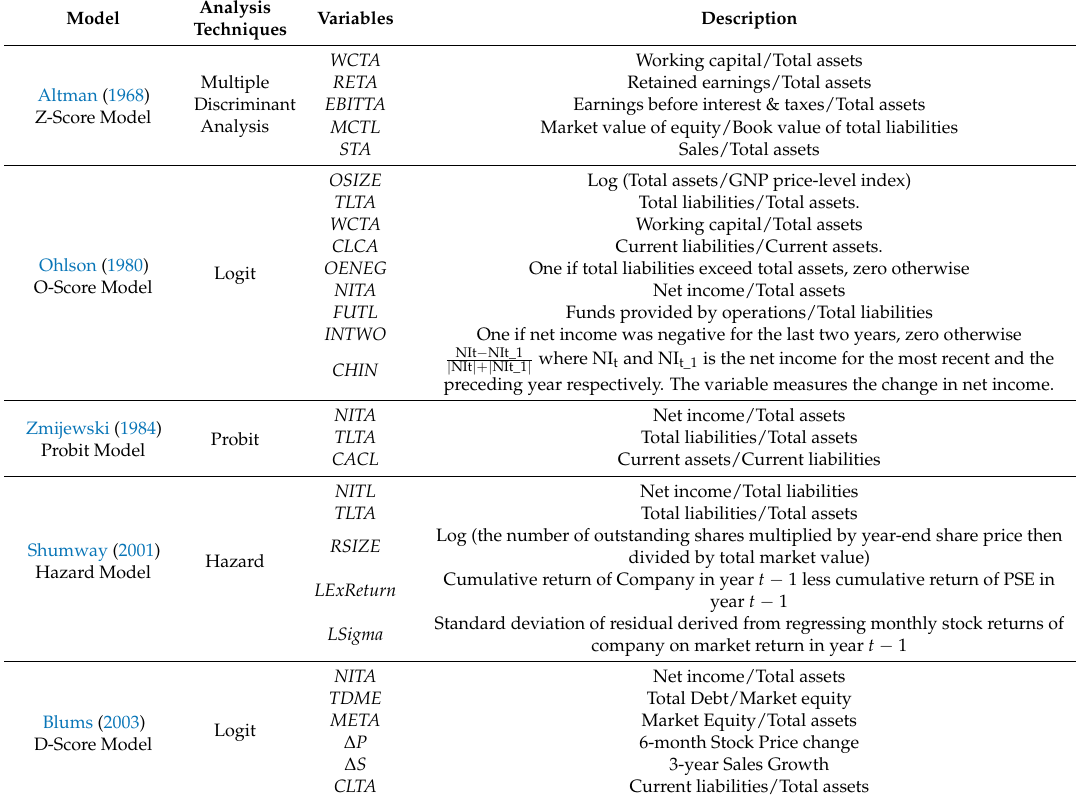
Table 2. Summary of distress prediction models and variables